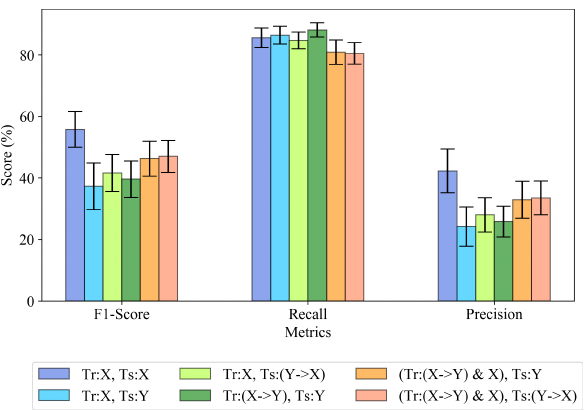
Figure 4. Temporal domain adaptation average ± standard deviation classification results in % with the identity term redefined as in Equation